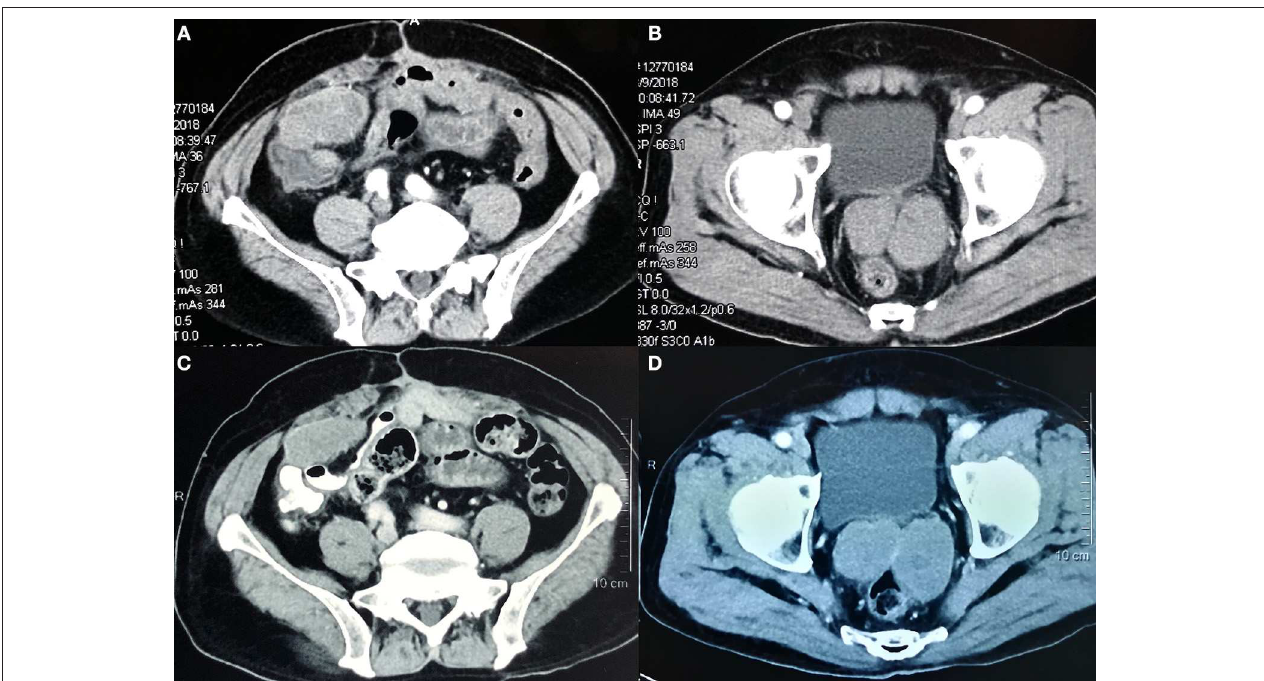
FIGURE 1 | Abdominal computed tomography scans showing the metastatic lesions in the abdomen and pelvic cavity before treatment (A,B) to a stable disease after 8 months of treatment with apatinib (C,D)